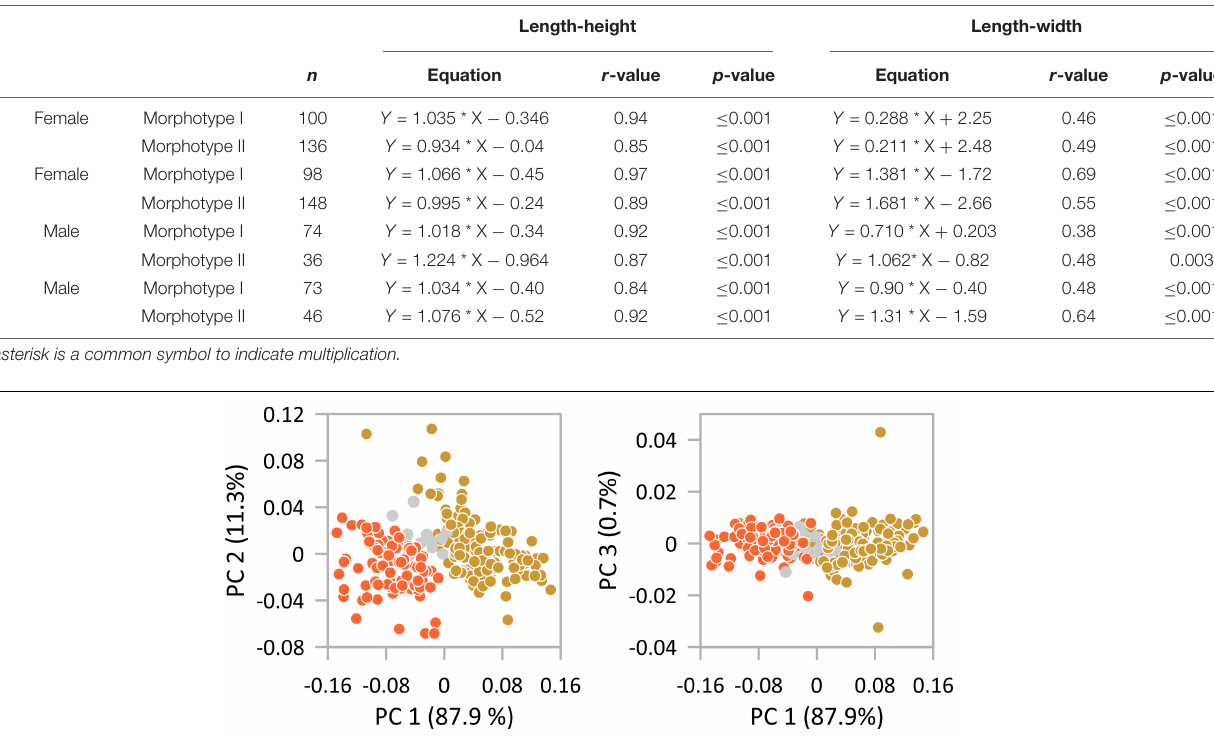
and 121 µ m, respectively. ISR provides the largest